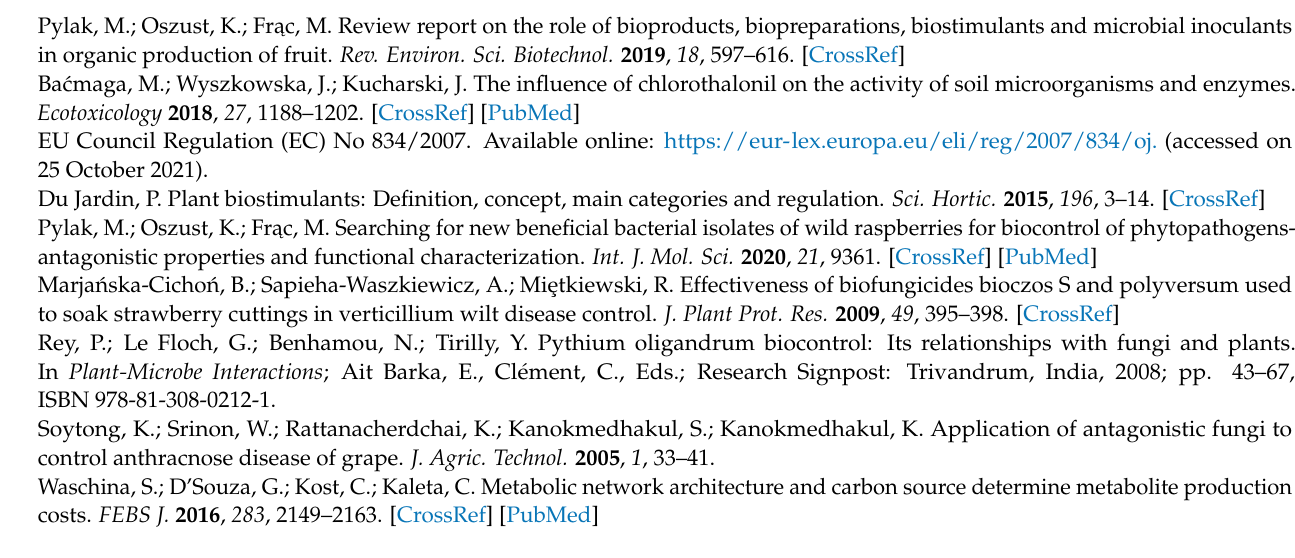
Figure A3. The early effect of the bacterial consortium on Polana raspberry plant growth in the pot experiment depended on the pathosystem and naturalization strategy applied. The average length of the stems, according to pathosystems Botrytis cinerea , Verticillium sp., Colletotrichum acutatum , Phytophthora sp., and all pathogens ( Botrytis , Verticillium , Colletotrichum , Phytophthora ) and without pathogens, within different biopreparation application strategies: no naturalization (NN), root inoculations (R), root inoculations and watering (RW), and watering (W). Error bars indicate a standard deviation, n = 3, different lowercase letters above the bars indicate differences among the particular pathosystem, and different capital letters above the bars indicate differences among the particular naturalization strategies (according to ANOVA with p <